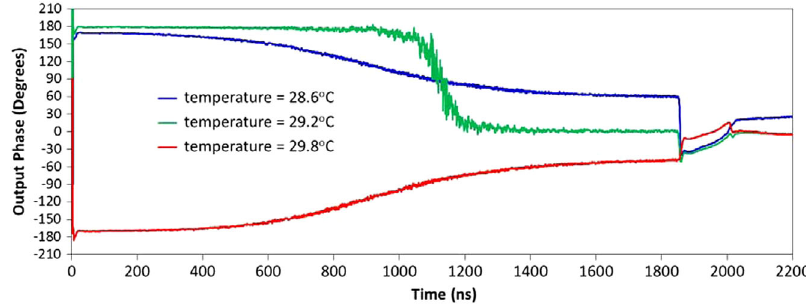
FIG. 13. Measured transmitted phase at XBOX-3 when pulse compressor cavities are detuned by heating above or below the temperature for perfect